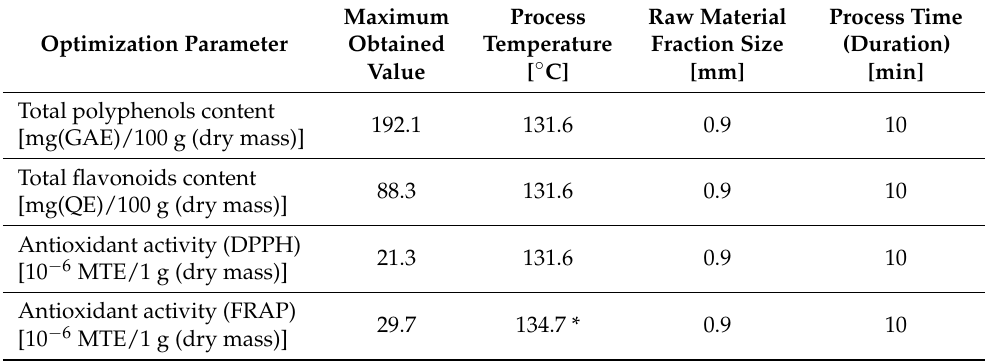
Table 9. Maximum test values with corresponding process parameters.